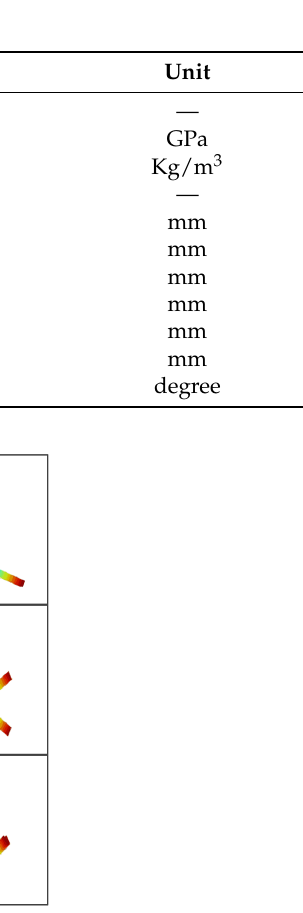
Figure 5. Vibration mode shapes at different response frequencies: (a) f = 1319.6 Hz (b) f = 2015.4 Hz (c) f = 2282 Hz.